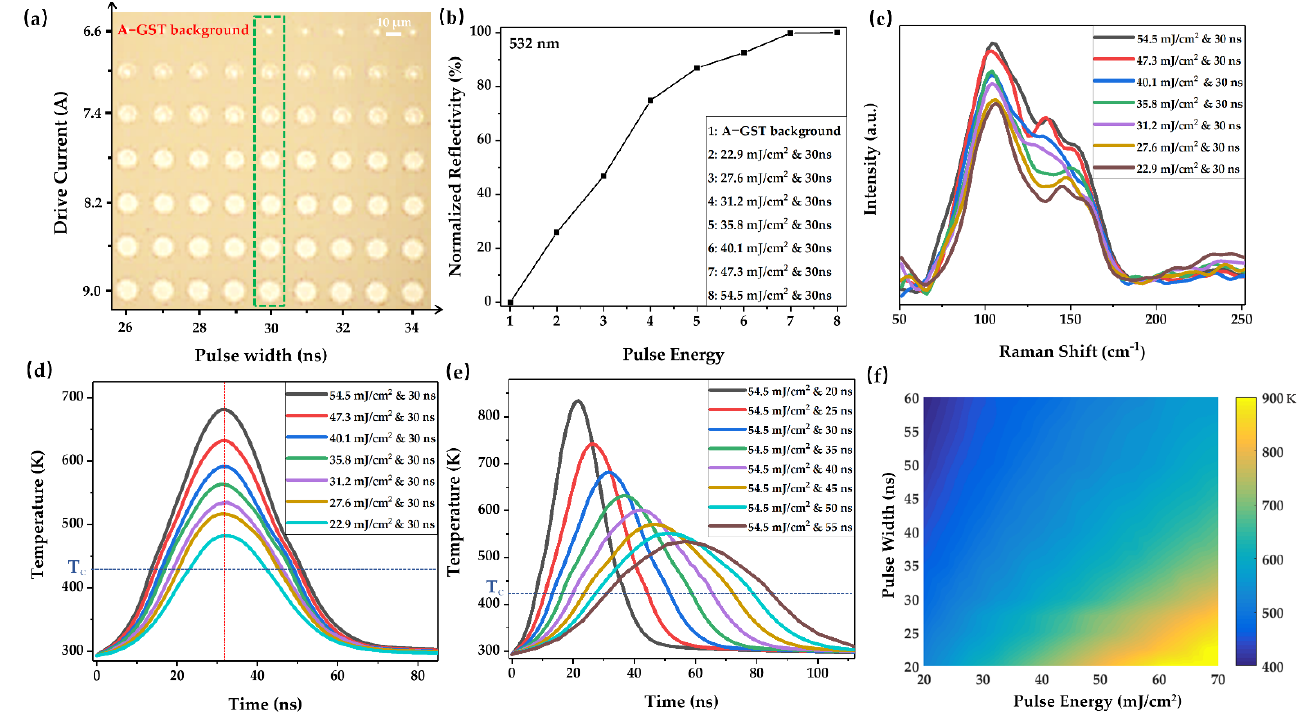
Figure 5. The irradiation marks on an a-GST background film characterized by ( a ) optical microscope image, ( b ) reflection spectra (normalized reflectivity), ( c ) Raman spectra and ( d ) thermal simulations; ( e ) thermal simulations for the maximum temperature variation at the top surface center of GST films induced with a certain laser fluence of 54.5 mJ/cm 2 and varying pulse widths; ( f ) maximum temperature variations at the top surface center simulated by varying pulse energy and pulse